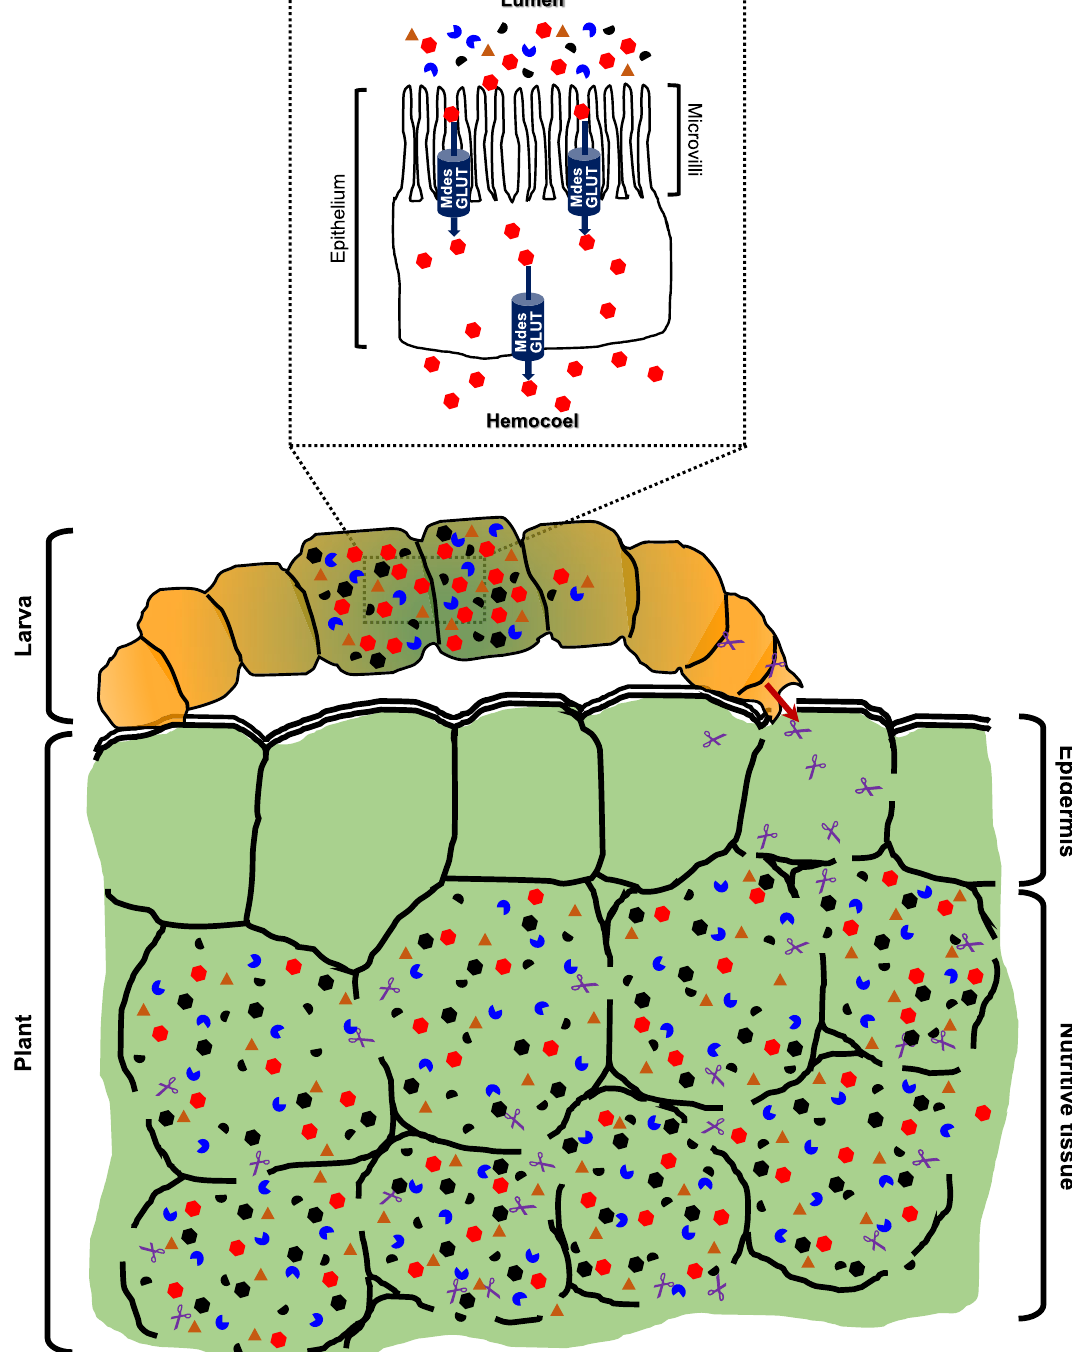
Figure 7. Model highlighting the role of MdesGH32 in the wheat-Hessian fly interaction. Virulent larva initiates feeding on the leaf sheath and secretes (red arrow) MdesGH32 (purple scissors) extra-orally into the plant tissue. MdesGH32 contributes towards the formation of a nutritive tissue by thinning and lysis of the epidermal and mesophyll cell walls by the inulinase activity against the plant cell wall inulin fructose polymers. Invertase activity of MdesGH32 converts sucrose, the main transport sugar into glucose (red filled hexagons) and fructose monomers that get phosphorylated (black filled hexagons). Rupture of the cell walls along with down-regulation of cell wall-associated genes increases permeability of the leaf tissue and creates a nutritive tissue rich in hexose sugar monomers, free amino acids (blue filled partial circles), polyamines (black filled semicircles) and miscellaneous solutes (orange filled triangles) that diffuse to the leaf surface where they are sucked up by the larva. Within the larval midgut (inset), the glucose transporter MdesGLUT (blue filled cylinder), actively transports plant- and insect-derived glucose from the lumen across the microvilli of the epithelial layer into the